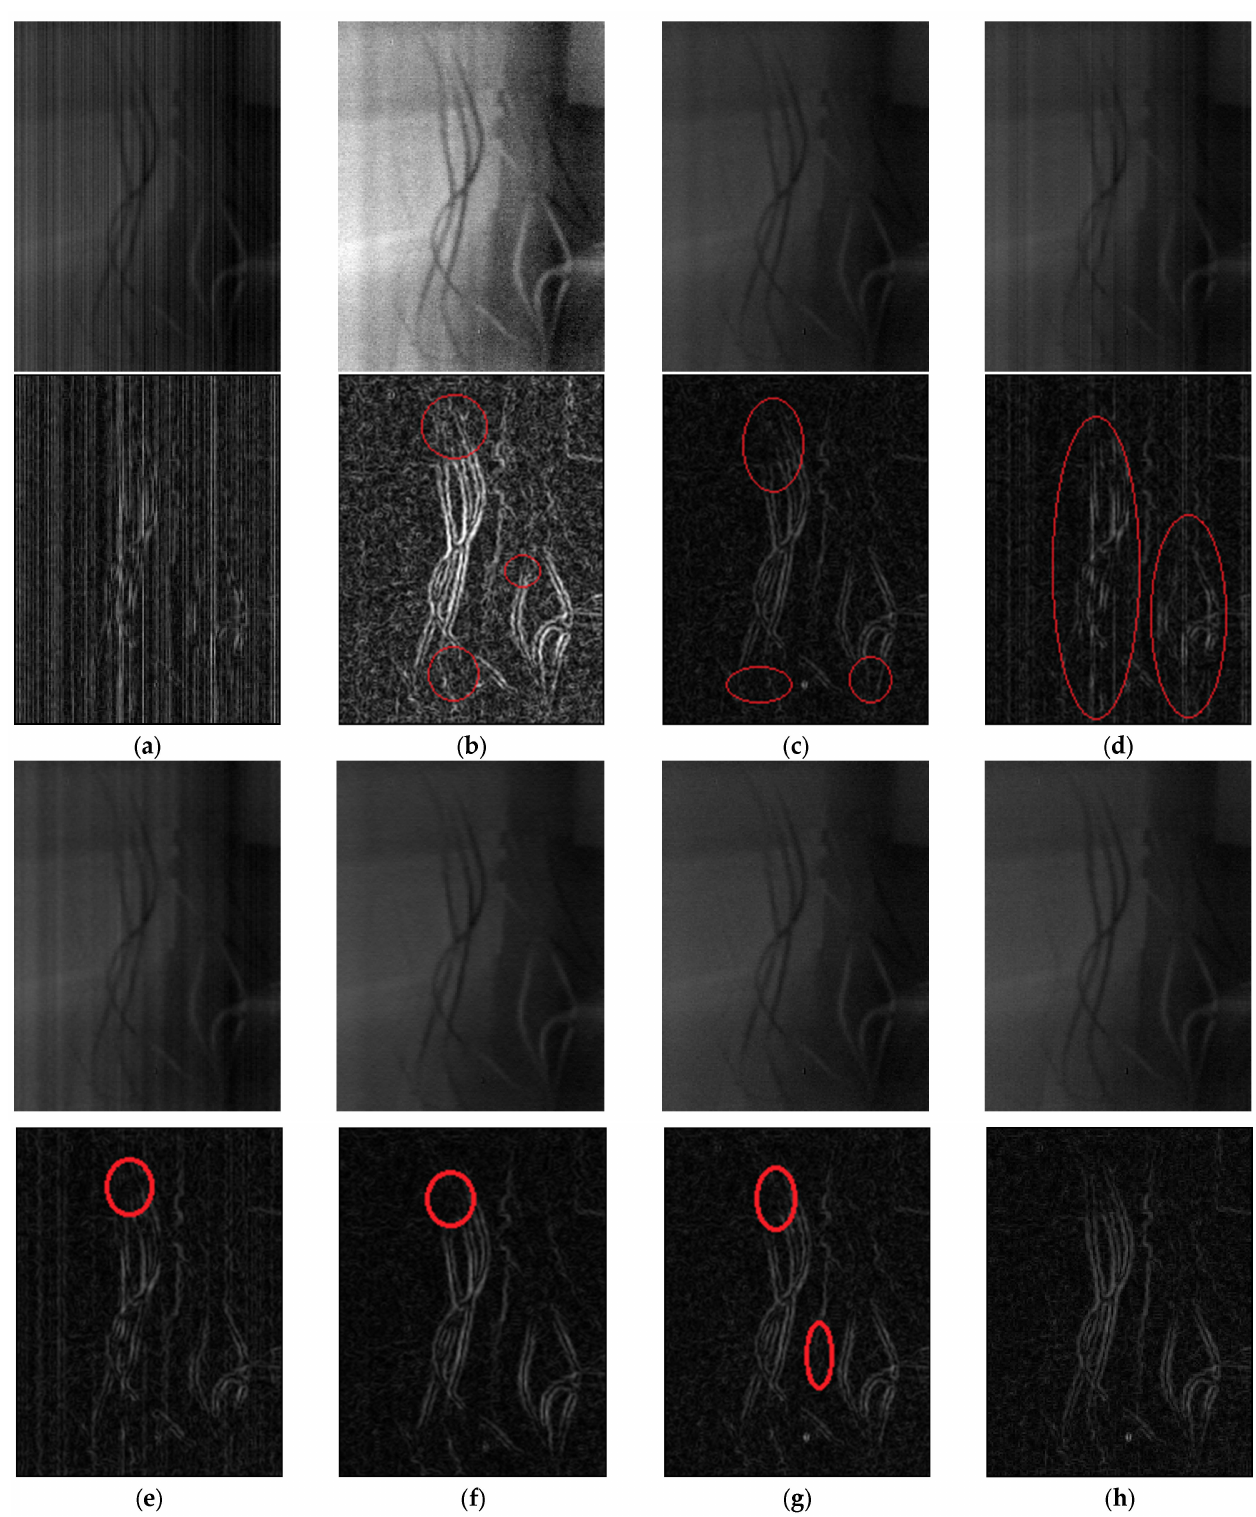
Figure 20. The correction results of the real data 2 and the edge detection images of the correction results. The red circle is our manual annotation of texture details in the image: ( a ) real data 2; ( b ) MHE; ( c ) 1D-GF; ( d ) SNRCNN; ( e ) ICSRN; ( f ) DLS-NUC; ( g ) SNRWDNN; ( h )